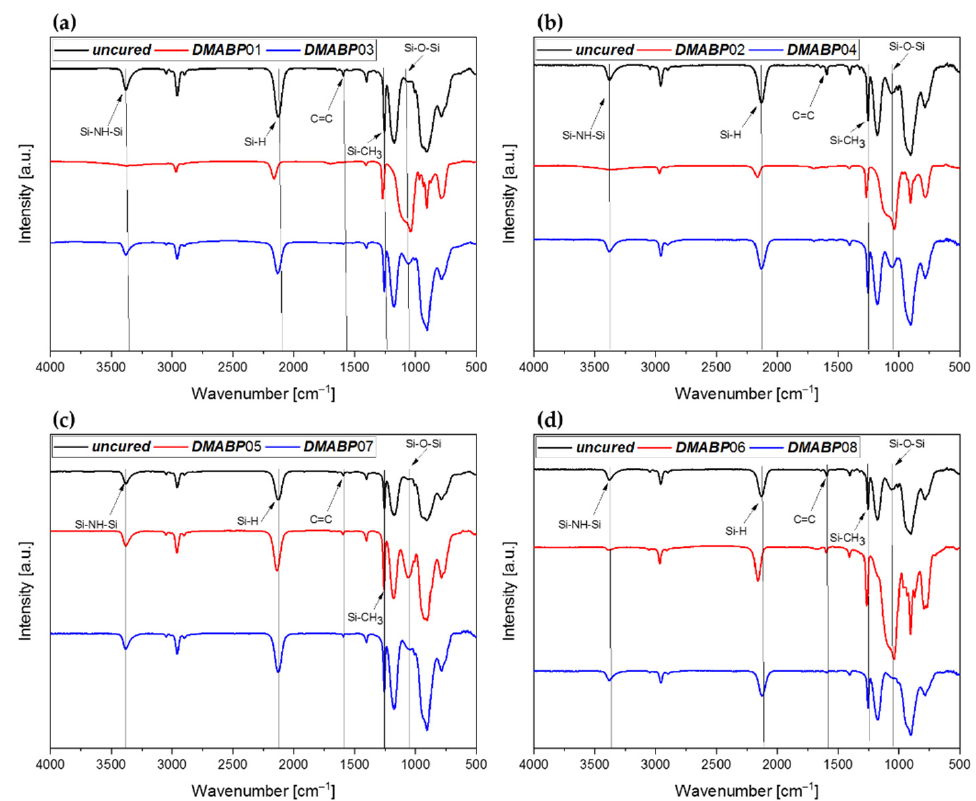
Figure 7. FITR spectra of the uncured and cured Durazane 1800 sample mixed with DMABP as photoinitiator. The red curves are samples cured in ambient atmosphere and the blue curves in nitrogen atmosphere. Black curves belong to the uncured samples. ( a ) DMABP 01 and DMABP 03, ( b ) DMABP 02 and DMABP 04 cured by a UV lamp ( λ = 385 nm). ( c ) DMABP 05 and DMABP 07, ( d ) DMABP 06 and DMABP 08 cured by a UV lamp ( λ = 405 nm).